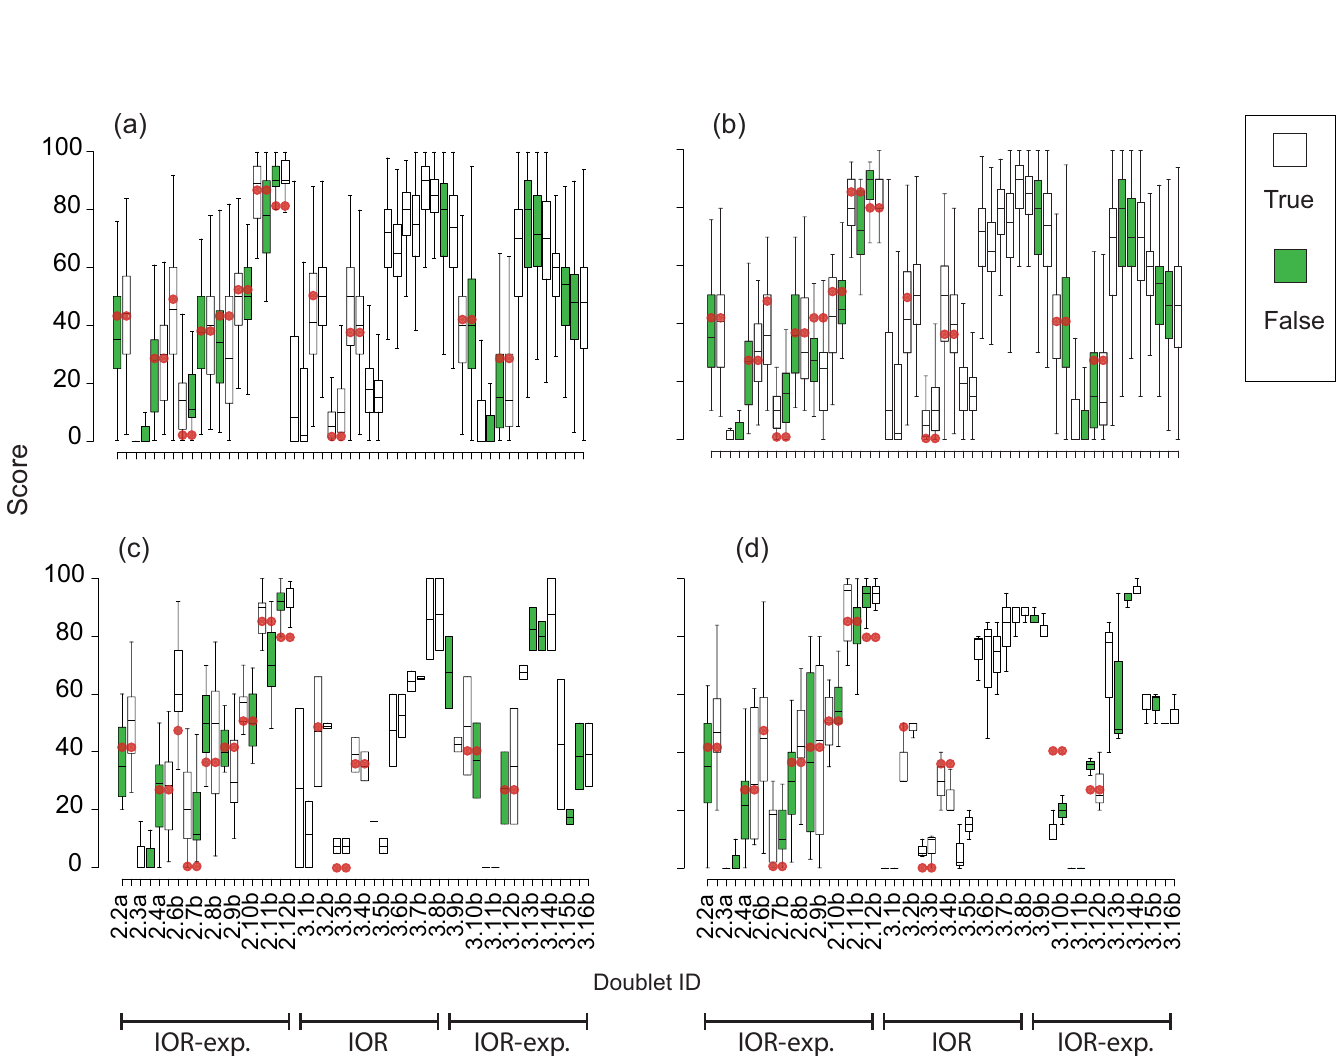
Fig 5. Plot of mean score per video clip doublet (with either ‘true’ or ‘false’ air exposure information) of a given reflex across all workshop participants (a), and then stratified by experience in scoring reflexes of fish: none (b); some (c); and experienced (d). Doublet ID includes a scoring video clip ID (2 or 3) and a running ID number for each doublet, with each clip of a doublet abbreviated by ‘a’ or ‘b’. Treatments include: ‘Intra-rater reliability with expectation bias’ (IOR-exp.), which refers to duplicated clips of the same fish and reflex with either true or false air exposure information; or ‘Intra-rater reliability’ (IOR), which refers to duplicated clips of the same fish and reflex and always true air exposure information. Where available, dots indicate the ‘silver standard’ scores which were averaged across three experienced, expert raters who scored 12 unmodified, original